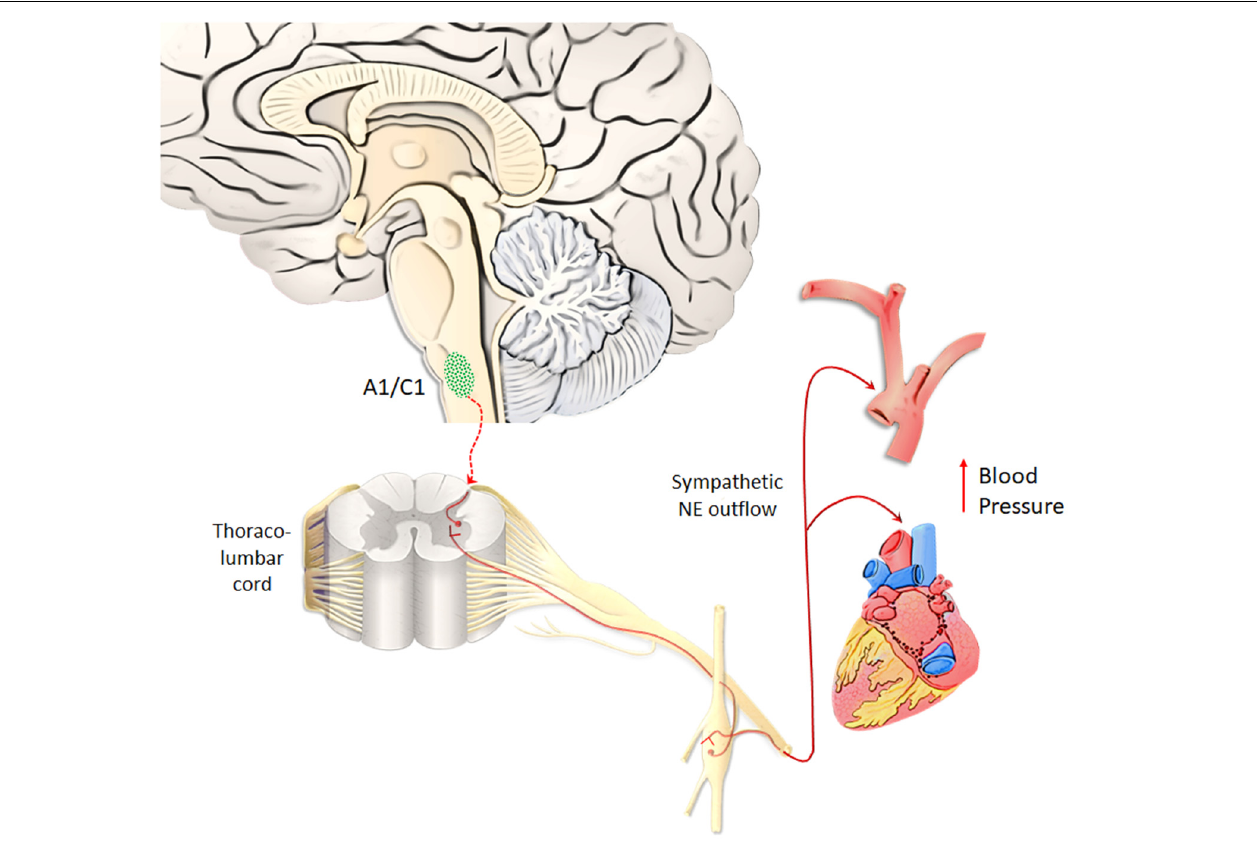
FIGURE 5 | A1/C1 neurons as a key center to control blood pressure. Hypertension produced by AMPHs largely depends on A1/C1 medullary neurons, which regulate the vascular tone, heart rate and blood pressure. NE released from A1/C1 neurons regulates blood pressure by directly activating sympathetic pre-ganglionic neurons (SPNs), which in turn stimulate the heart and produce contraction of smooth muscle within blood vessels. Due to a powerful NE-release by AMPHs, these peripheral targets innervated by the A1/C1 complex are strongly activated during AMPHs administration (Liu and Varner, 1996). This response occurs in a sensitized manner following repeated dosing of AMPHs (Marchese et al.,